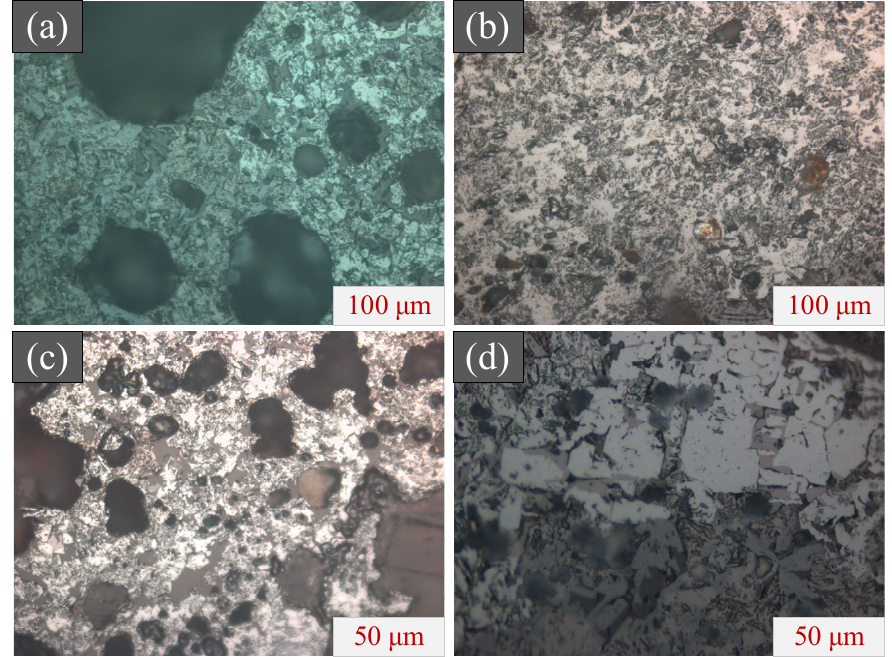
Figure 6. Microstructure of finished sinter from conventional and pre-pelletizing granulation sintering at 28% of MCI proportion. ( a ) conventional granulation sinter; ( b ) pre-pelletizing granulation sinter; ( c ) MCI pellet sinter; ( d ) conventional material and MCI pellet connection.